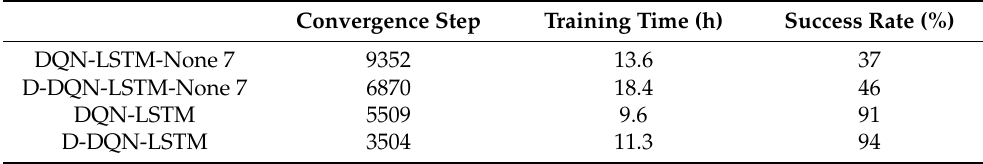
Table 3. Comparison of algorithms performance with and without policy